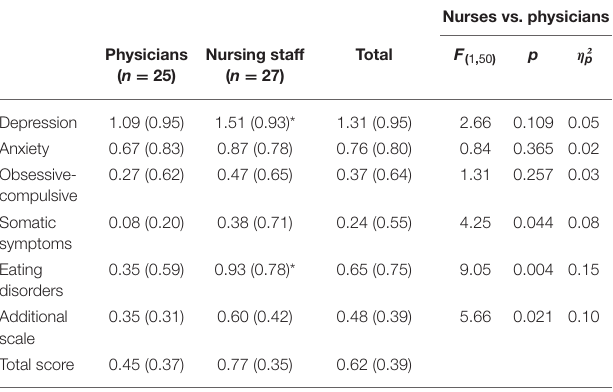
TABLE 1 | Mean scores and standard deviations for general mental health problems in nurses and physicians.